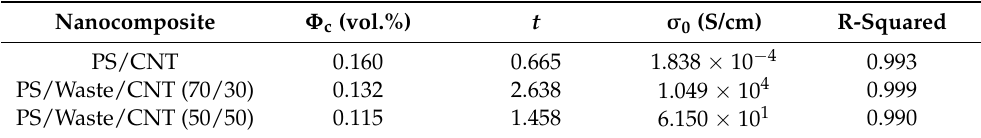
Table 1. Fitted percolation parameters of the power-law model (Equation